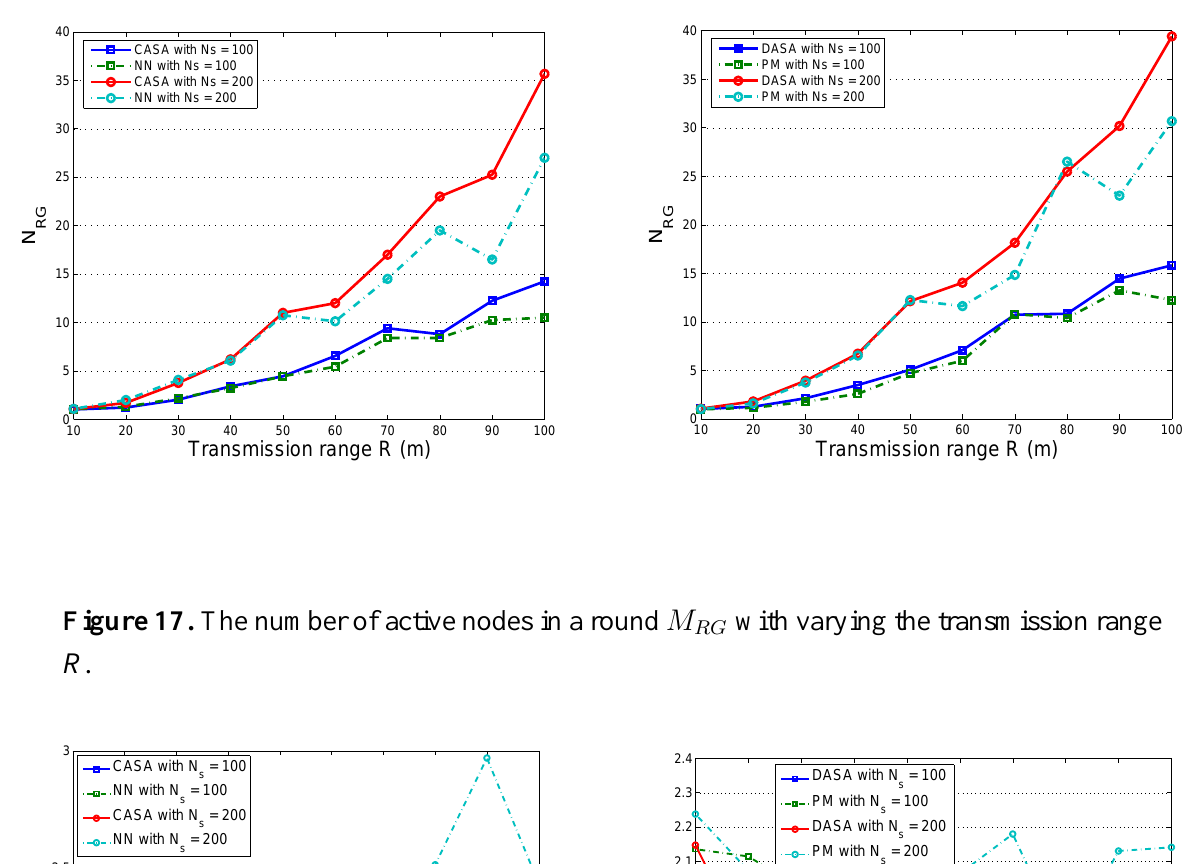
Figure 16. The comparison of the average number of round groups N posed scheduling schemes and those using the analytical models.